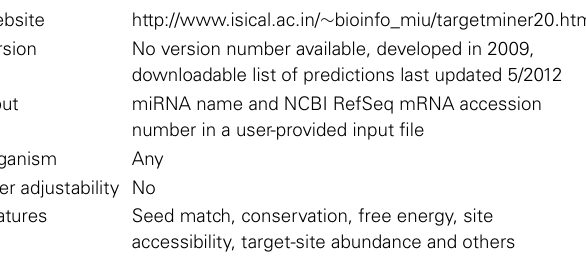
Table 7 | Profile of